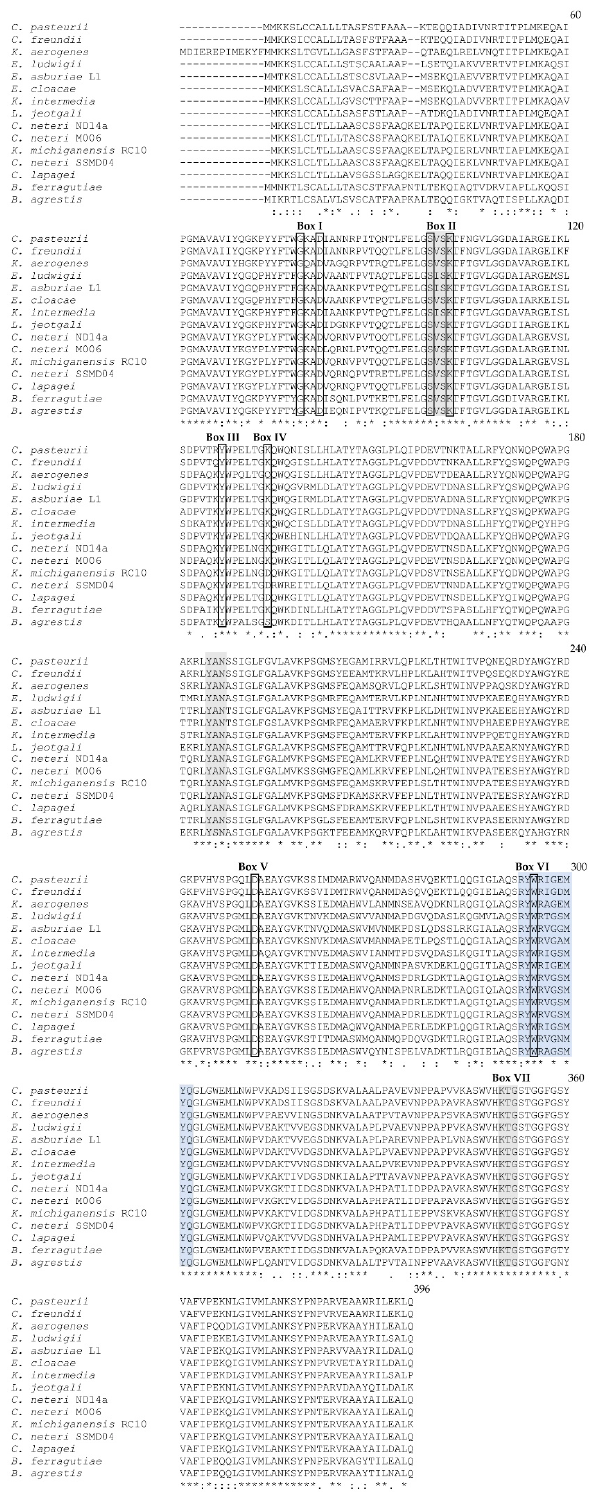
Figure 1. ClustalW multiple alignments of amino acid sequences of class C β -lactamases with annotated β -lactamases from three C. neteri environmental isolates (SSMD04 JT31_10470, ND14a